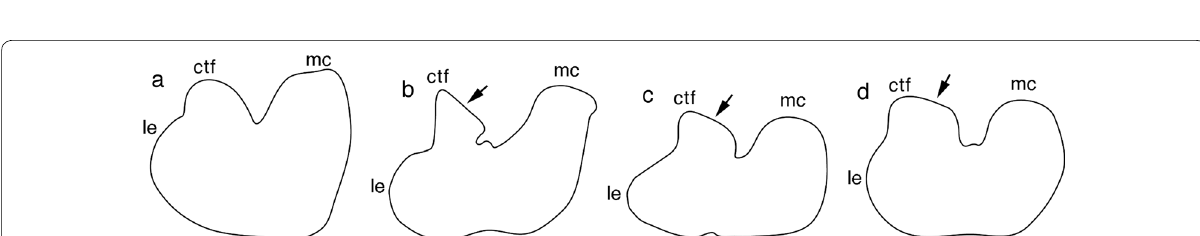
Fig. 20 Comparison of the distal outlines of the left femora of a basal saurischian ( a ) and several non-sauropodan sauropodomorphs ( b – d ). a Eoraptor (right femur reversed; based on Sereno et al. 2013). b Plateosaurus (right femur reversed; based on Huene 1926). c Coloradisaurus (based